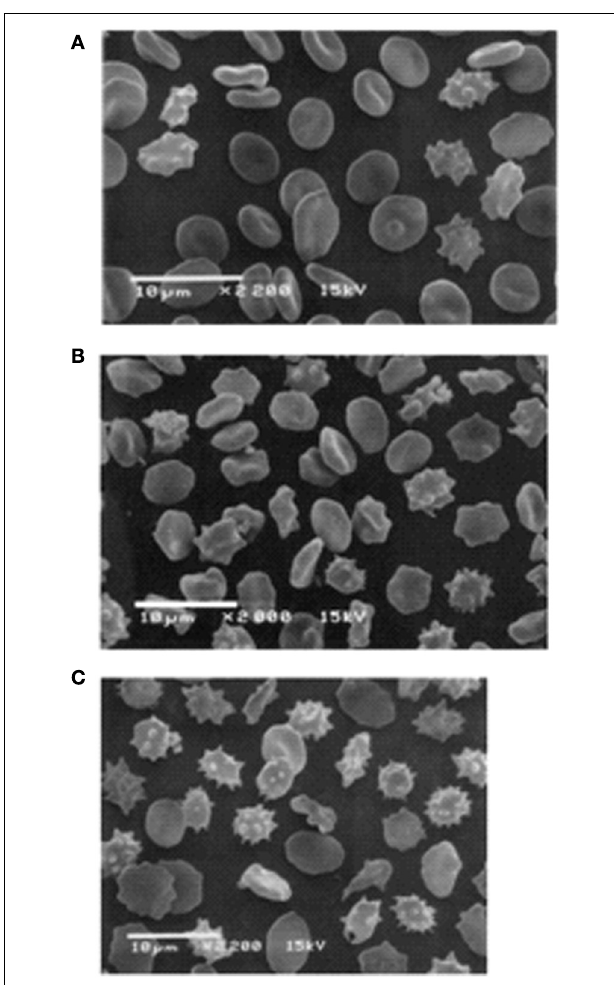
FIGURE 3 | Scanning electron microscope pictures of RBC. Stored RBC on the 5th (A) , 14th (B) , and 42nd (C) day of storage. (A) Discocytes dominate among the cell population, and only a few irreversibly changed RBC can be seen. (B) Numerous echinocytes and spheroechinocytes can be seen. (C) Spheroechinocytes and degenerated forms dominate among irreversibly changed cells. Cells stored in adenine saline solution (AS-3 contains saline, adenine, glucose, phosphate, and citrate). Reprinted from Berezina et al. (2002), with permission from Elsevier.